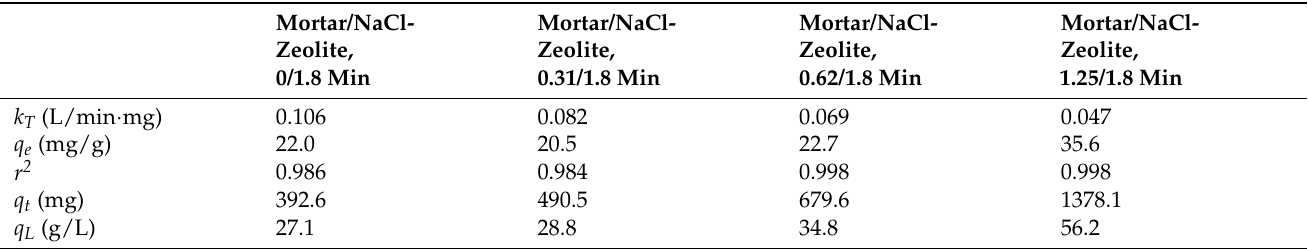
Table 5. Adsorption constants for Cu 2+ removal with mortar/Na-zeolite dual media according to EBCT.